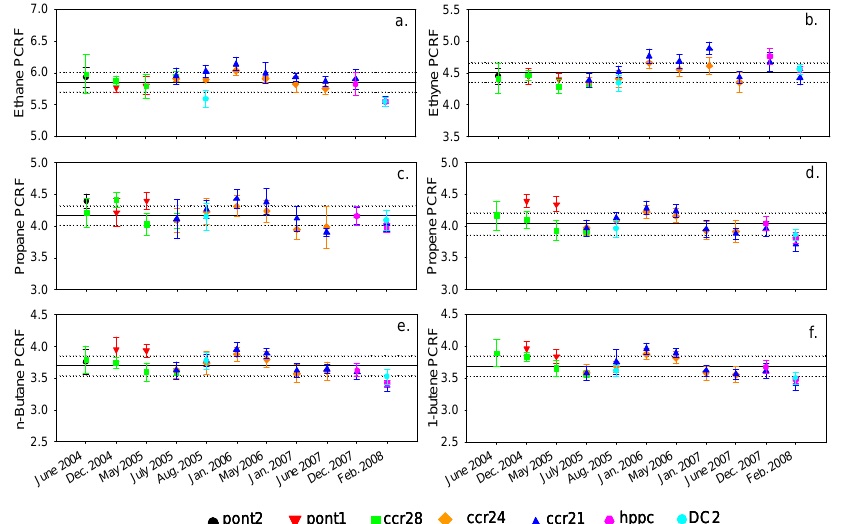
Fig. 2. Per carbon response factors (PCRF) of (a) ethane, (b) ethyne, (c) propane, (d) propene, (e) n-butane, and (f) 1-butene in different standards (pont1, pont2, ccrXY, hppc, DC2) analyzed in the UNH laboratory during 2004–2008. The reference lines are the mean ± 1 standard deviation of the PCRF included in each plot. The symbols ± error bars are the mean PCRF ± 1 relative standard deviation for the individual standard analyzed during the specified time